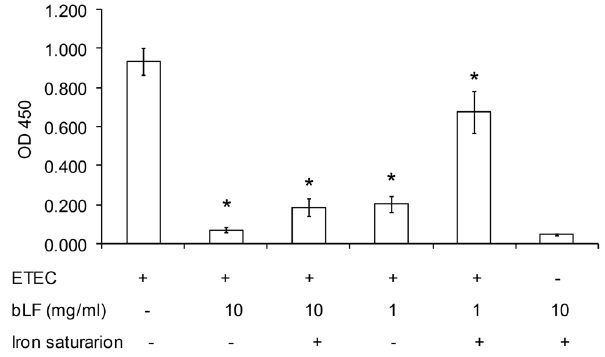
Figure 3. Inhibitory ability of bovine lactoferrin (bLF) on the binding of LT produced by ETEC H10407 to GM1 by GM1- ELISA. The wells were coated with 500 ng of GM1 and ETEC H10407 was incubated on LB broth with 100 m L of bLF (10 mg/mL or 1 mg/mL) with and without iron (4:1 molar ratio of iron to lactoferrin) and incubated at 37 u C overnight. The absorbance was read at 450 nm in an ELISA plate reader. Values are mean 6 standard desviation of three independent assays. *, p , .001 for the comparison of bLF groups with and without iron saturation vs. LT produced by ETEC group, by unpaired t